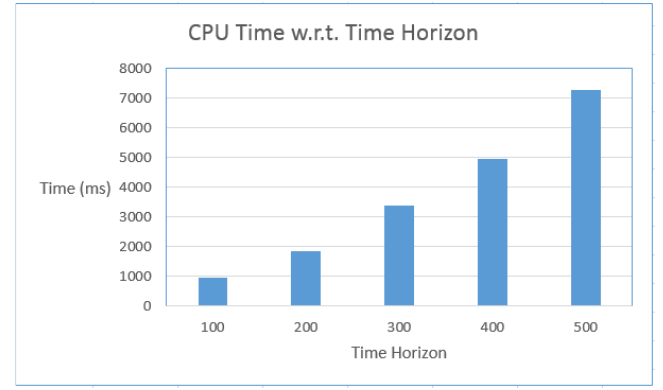
Figure 8. CPU time with respect to time horizon (Problems 11~15).